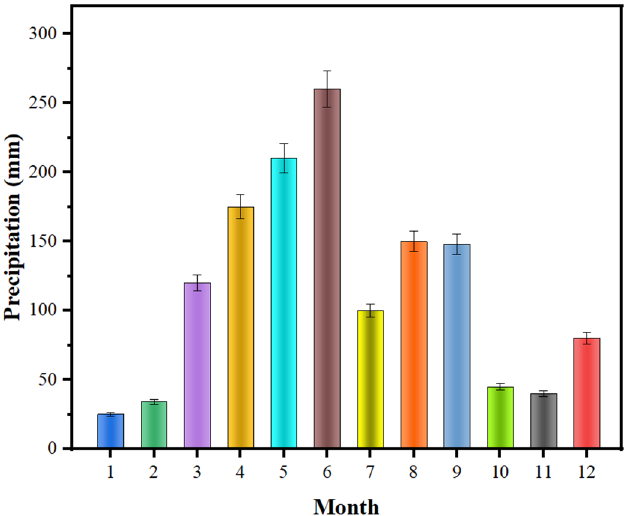
Figure 2. Monthly distribution of precipitation outside the forest ( Data from Changsha Meteorological Bureau ).